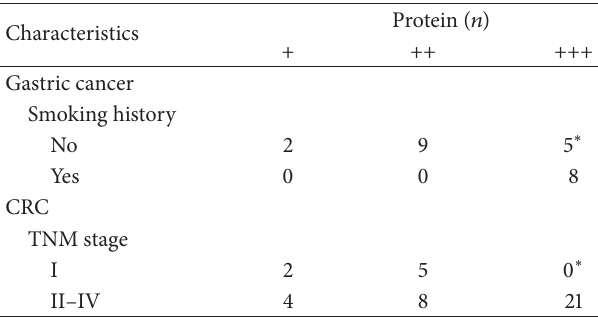
Table 4: The relationship of DUOX2 expressions in gastric cancer and CRC with clinicopathological